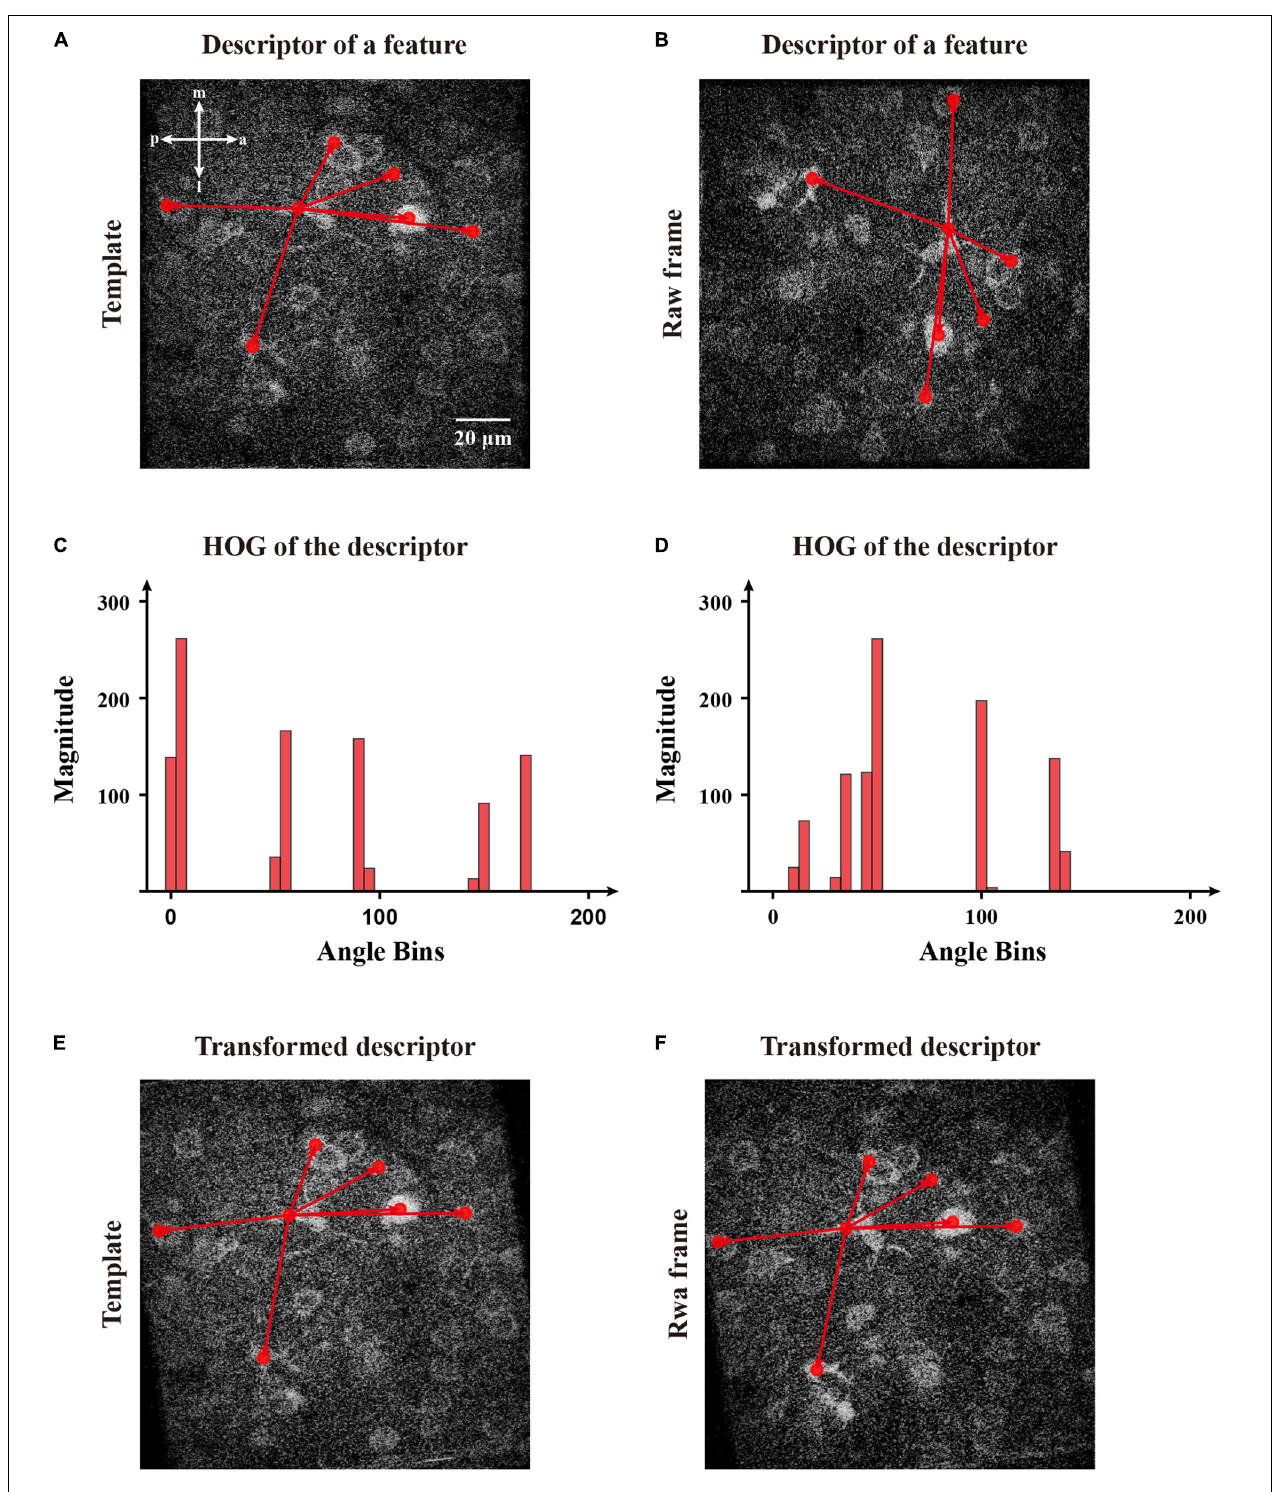
FIGURE 8 | The calculation of direction of the selected features and transformation of corresponding descriptors for matching. (A) The features obtained by FIFER; features are marked by red dots. (B) A raw frame with a rotation deviation and its corresponding features. The red arrows represent a two-dimensional descriptor of the selected feature in panels (A,B) . (C) The histogram of magnitude in directions bins of the template feature’s descriptor. (D) The histogram of magnitude in directions bins of the raw frame feature’s descriptor. (E) The descriptor of the selected template feature within its main direction. (F) The transformed descriptor of the selected frame feature within its main